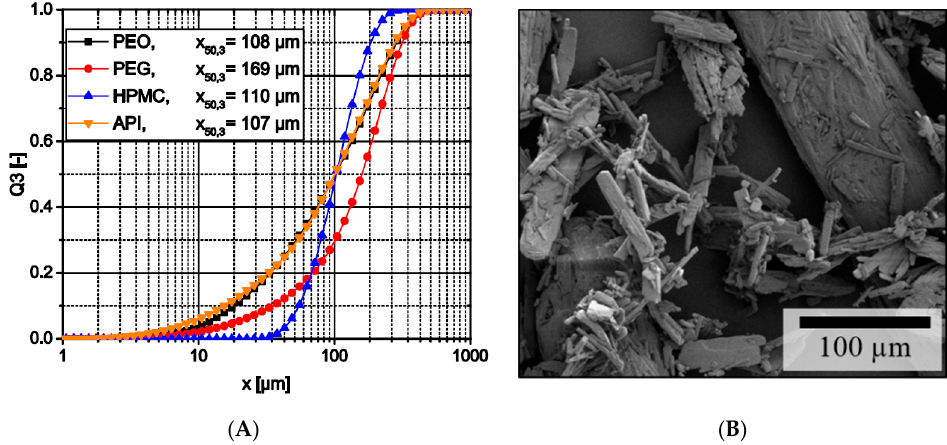
Figure 1. ( A ) Particle size distribution of raw materials; ( B ) SEM image of theophylline crystals.